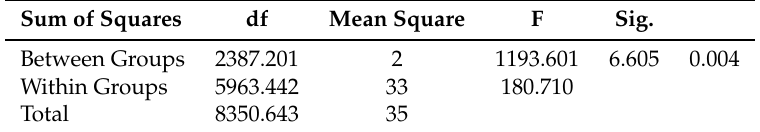
Table 10. ANOVA analysis of Random, NN and our Regression with respect to average convergence.